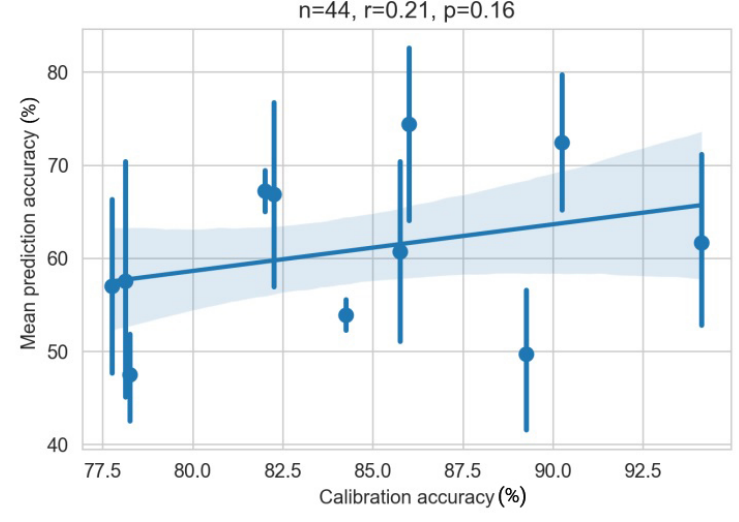
Figure 8. Pearson correlation of calibration and mean prediction accuracy. Each dot with line represents the four posters for one participant. The dot is the mean and the lines are the min and max values of the four posters.